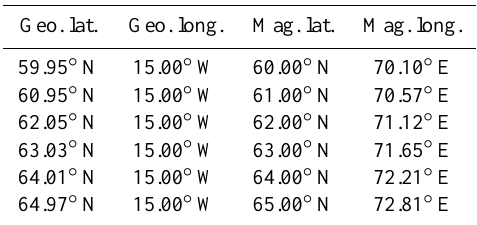
Table 2. Locations of the model runs. Geo. lat. Geo. long. Mag. lat. Mag.